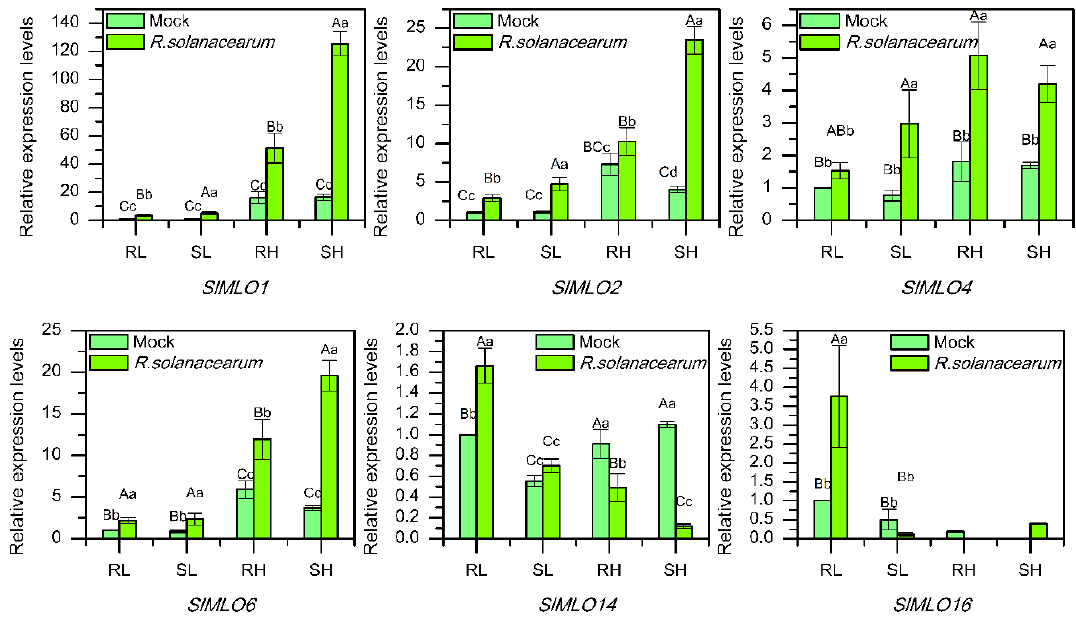
Figure 5. The relative expression levels of six SlMLO genes in resistant and susceptible tomato lines inoculated with R. solanacearum . R, resistant line; S, susceptible lines; L, leaf; H, whole seedling. Error bar indicates standard deviation. The uppercase and lowercase letters above the error bars indicate statistically significant differences (Tukey’s test, p < 0.01 and p < 0.05). The replication data of SlMLO16 expression analysis in whole seedlings were missed.